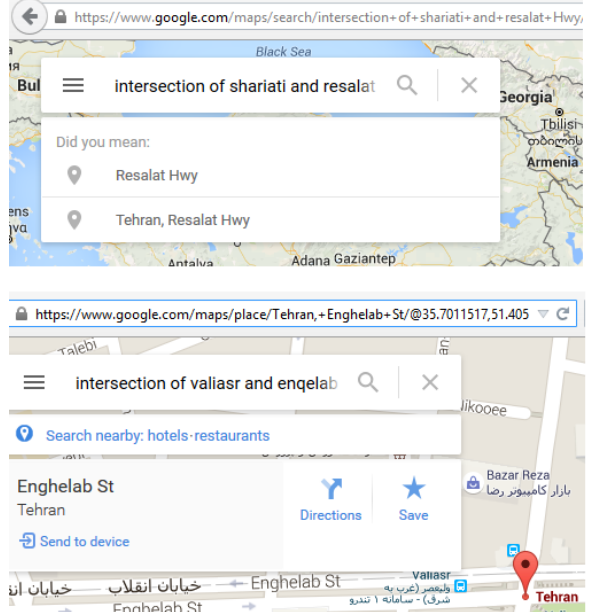
Figure 2 different behaviour of the Google against queries with same